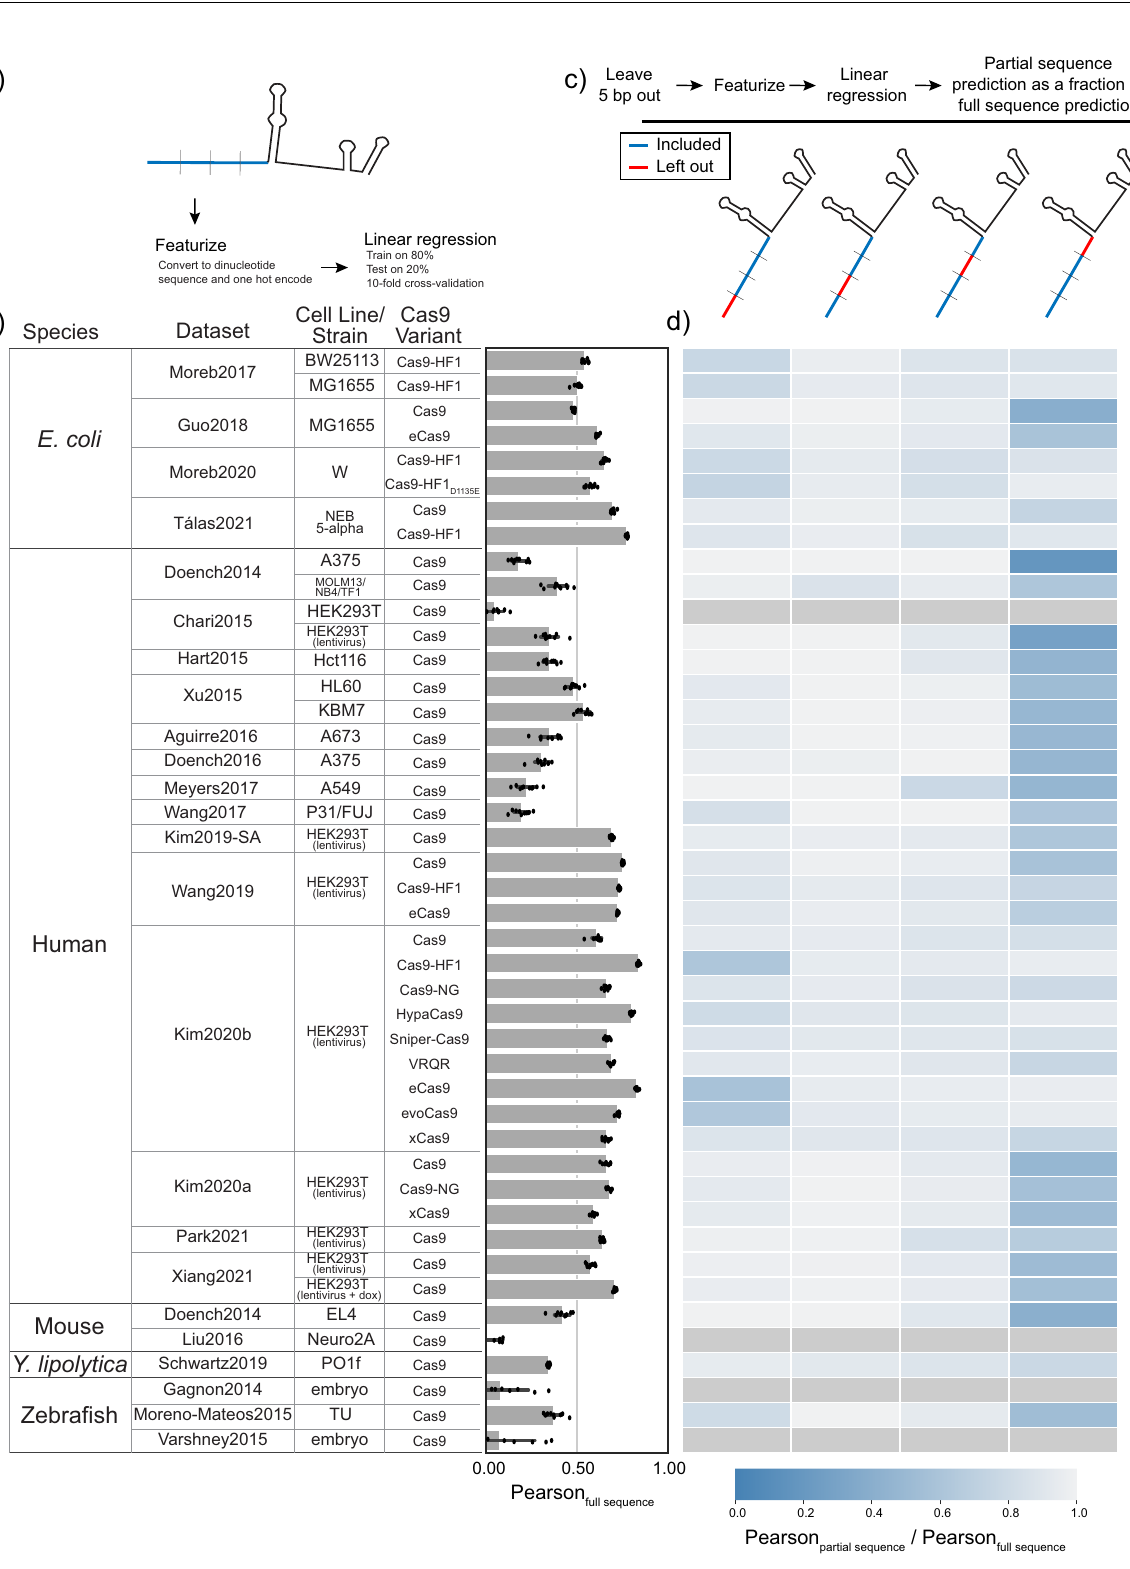
Fig. 4 The PAM proximal portion of the gRNA provides most of the predictive power of the sequence. a The 20 bp targeting sequence of each gRNA was converted to a dinucleotide one hot matrix and used to predict activity with a linear regression. For each dataset, 80% of gRNA were randomly assigned to a training group while the remaining 20% were used as a test group. Predicted activity was compared with actual activity using Pearson correlation coef fi cient and this process was repeated 10 times to achieve 10-fold cross validation. b The average of the 10-fold cross validation is shown for each dataset (along with individual results, dots). Error bars show the standard deviation of each cross validation. c We then repeated this analysis but left out 5 bp at a time. d The heatmap shows the averaged Pearson with 5 bp left out (Pearson partial sequence ) as a fraction of the averaged Pearson using all 20 bp (Pearson full sequence ). In cases where the Pearson full sequence average was close to zero, we excluded these datasets from further